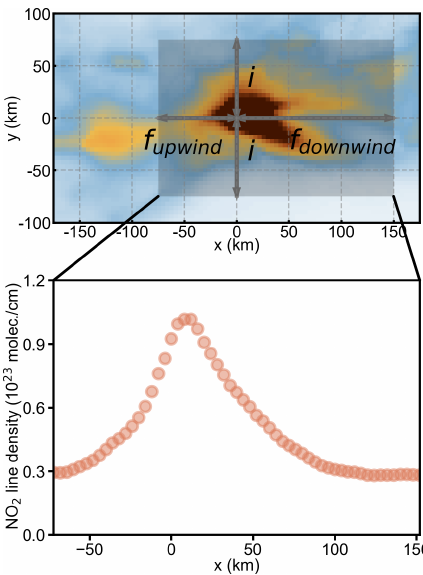
Figure 3. Sketch of the definition of line densities. For each wind direction, mean NO 2 VCDs are integrated in across-wind direc- tion y over the interval i , resulting in line densities LD( x ). The fit is performed over the entire upwind interval ( f upwind ) and down- wind interval ( f downwind ). The city center is the coordinate origin. The top panel shows the NU-WRF tropospheric NO 2 VCDs around New York City under southwesterly wind; however the image is ro- tated by 45 ◦ in the clockwise direction to present NO 2 VCDs in an upwind–downwind direction. The city of Philadelphia and Long Island are located in the upwind and downwind direction, respec-